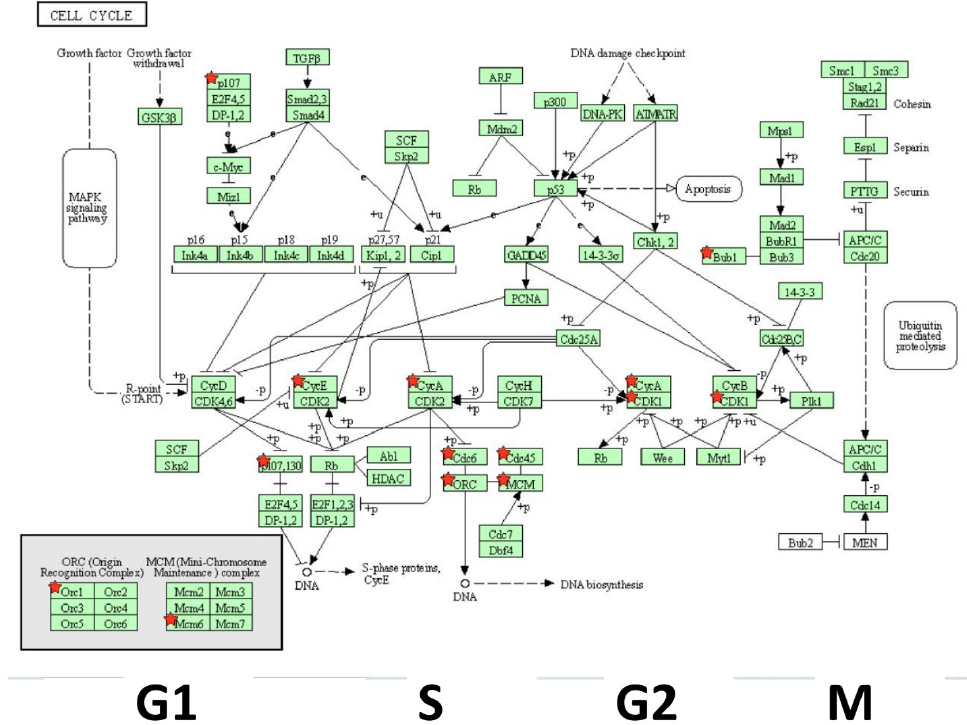
Figure 10. DEG - down-regulated transcripts by GNE-140 vs. controls in MDA-MB-231 cells by pathway analysis show loss of function in cell cycle related genes. Down-regulated DEGS are denoted (red stars) within the KEGG cell cycle pathway.